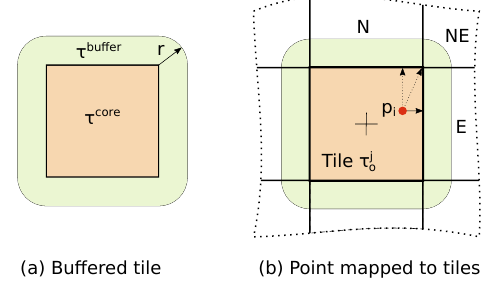
Figure 1. Spatial decomposition into buffered tiles Algorithm 1: Map point to buffered